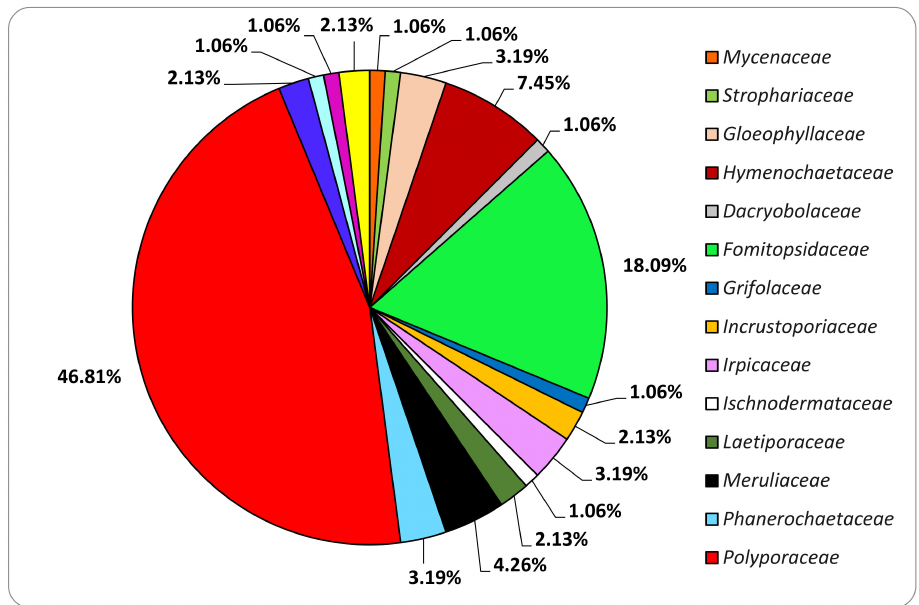
Figure 4. Families represented in the set of isolated strains included in this study.